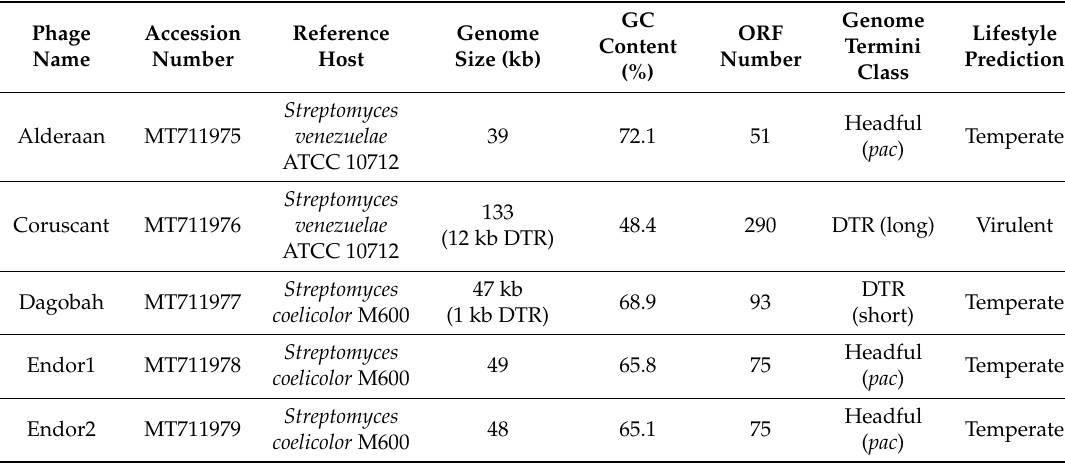
Table 2. Basic genome features of the five phages. Open reading frames (ORFs) were predicted using Prokka [25] and were later manually curated. Protein domains encoded in ORFs were identified using RPS-BLAST against the Conserved Domain Database (CDD). The type of genome ends was determined using Phage Term [29]. The lifestyle of each phage was predicted by the machine-learning based program PhageAI